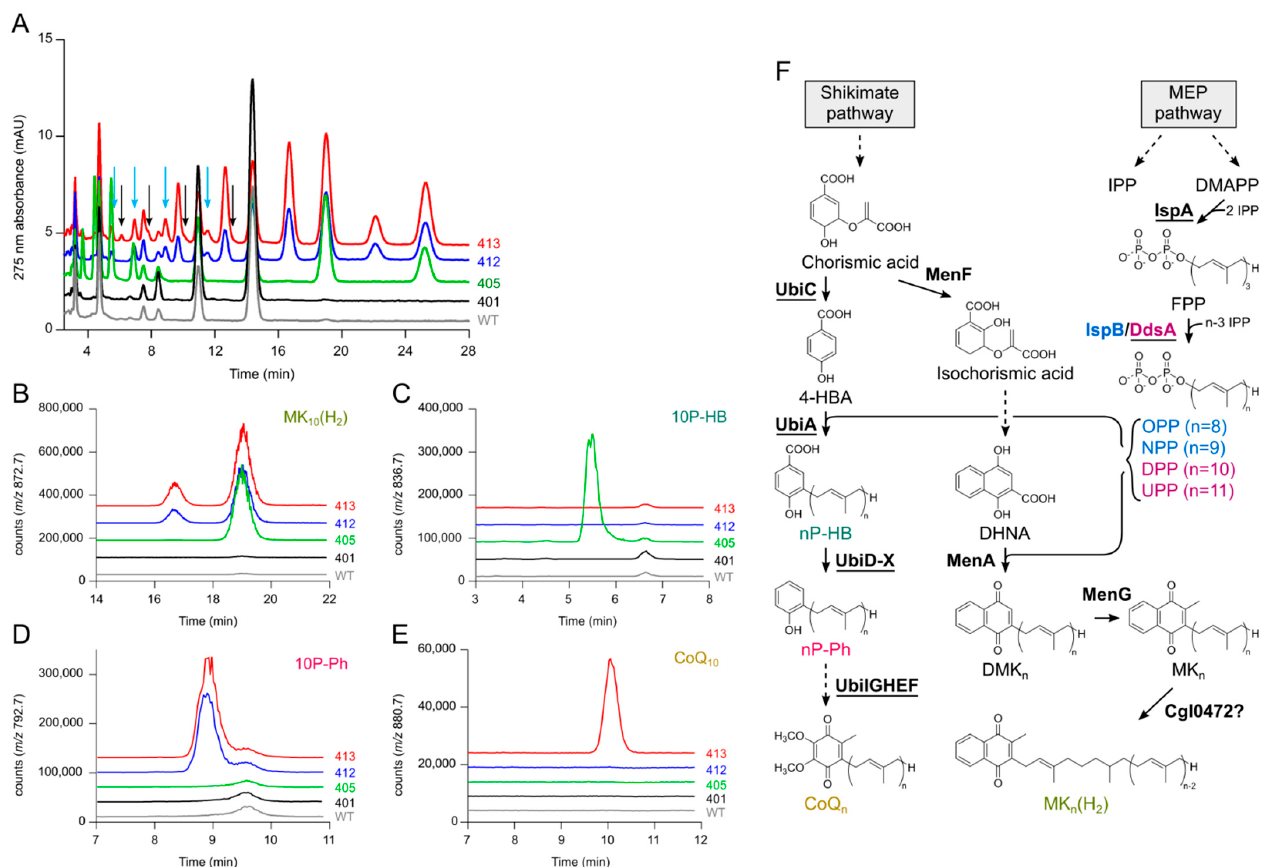
Figure 1. LC–MS analysis of quinone extracts of C. glutamicum strains WT, UBI401, UBI405, UBI412, and UBI413 to identify metabolic bottlenecks in CoQ 10 production. ( A ) Overlay of UV chromatograms with black arrows pointing at CoQ 8-11 peaks and blue arrows pointing at 8P-Ph–11P-Ph peaks to indicate the low flux from nP-Ph to CoQ n ; ( B – E ) SIM overlays of NH 4+ adduct of MK 10 (H 2 ) ( m / z = 872.7, B ); NH 4+ adduct of 10P-HB ( m / z = 836.7, C ); NH 4+ adduct of 10P-Ph ( m / z = 792.7, D ); NH 4+ adduct of CoQ 10 ( m / z = 880.7, E ); ( F ) Metabolic pathway of CoQ n and MK n (H 2 ) biosynthesis. Enzymes are in bold, heterologous enzymes are under- lined. As IspB mainly synthesizes NPP and OPP and DdsA mainly synthesizes DPP and UPP, the enzymes and corresponding direct products were marked with matching colors. The ques- tion mark indicates that the reaction attributed to Cgl0472 is not experimentally proven.